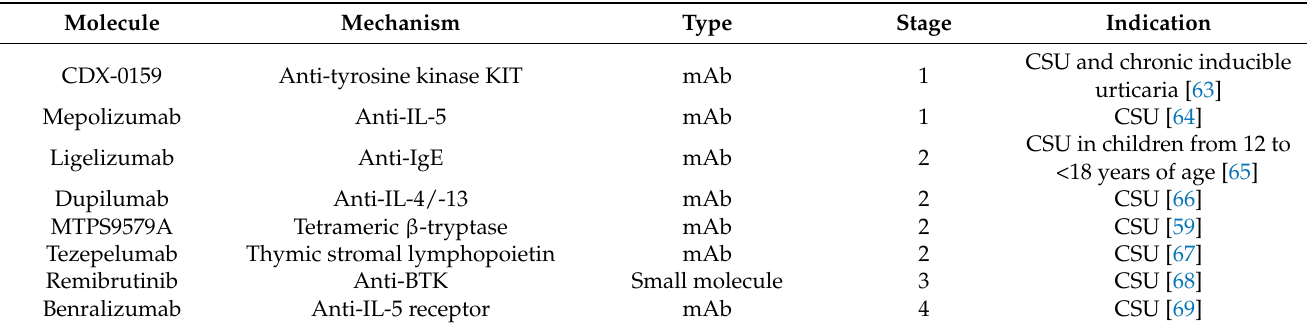
Table 1. Therapeutic agents currently under investigation in clinical trials for the treatment of chronic spontaneous urticaria, May